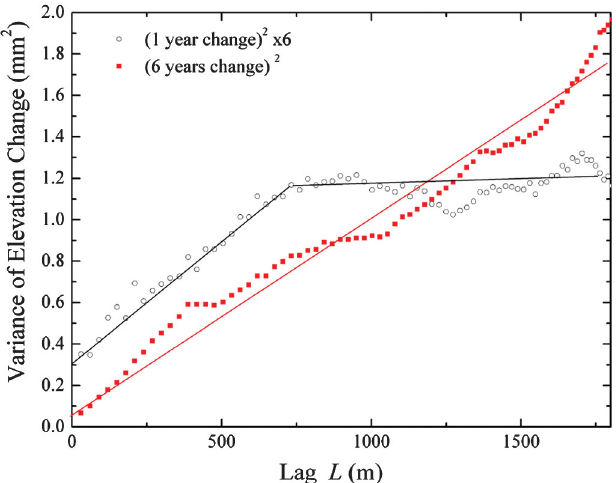
Fig. 20 the exponent (cid:2) of a power-law fit h dY 2 ð L Þi / L (cid:2) varies between 0.7 and 1.0.